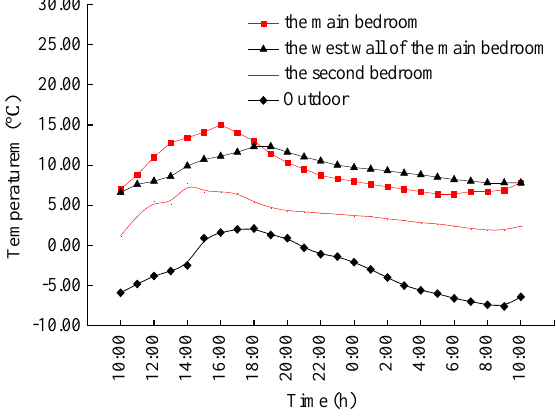
Figure 6. Indoor and outdoor temperatures of the residential building.